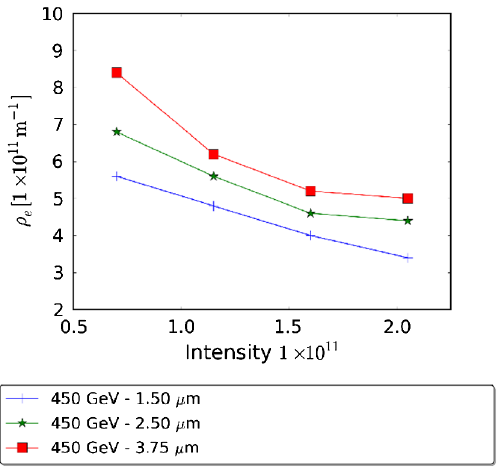
FIG. 18. Instability threshold values for the bending magnets at 450 GeV and different transverse